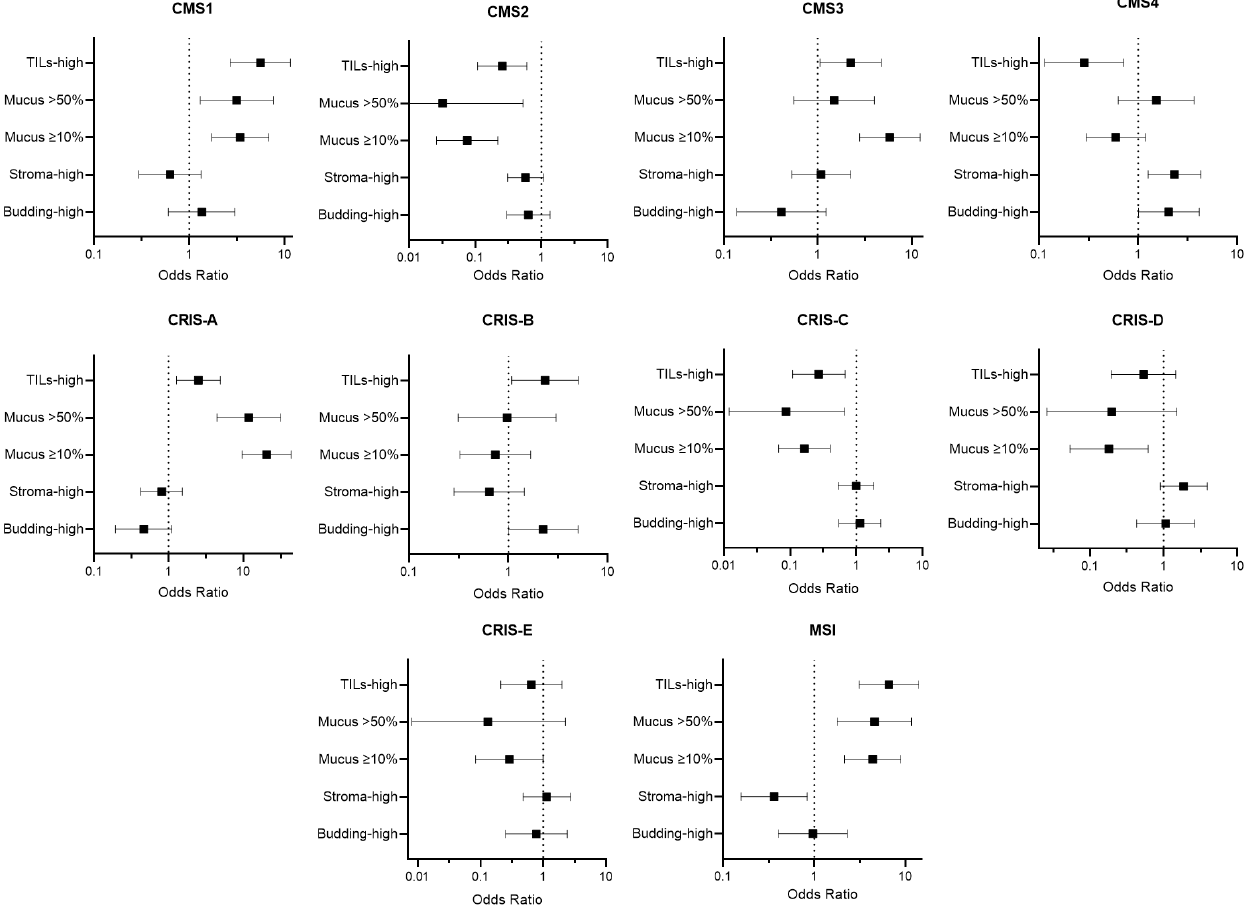
Figure 1. Odds ratios with 95% confidence interval calculated as the likelihood of classification into a certain molecular subtype (CMS, CRIS, or MSI) in the case of assignment into the highest histopathologic score category (i.e., TILs-high, mucus > 50%, mucus ≥ 10%, stroma-high and budding-high).